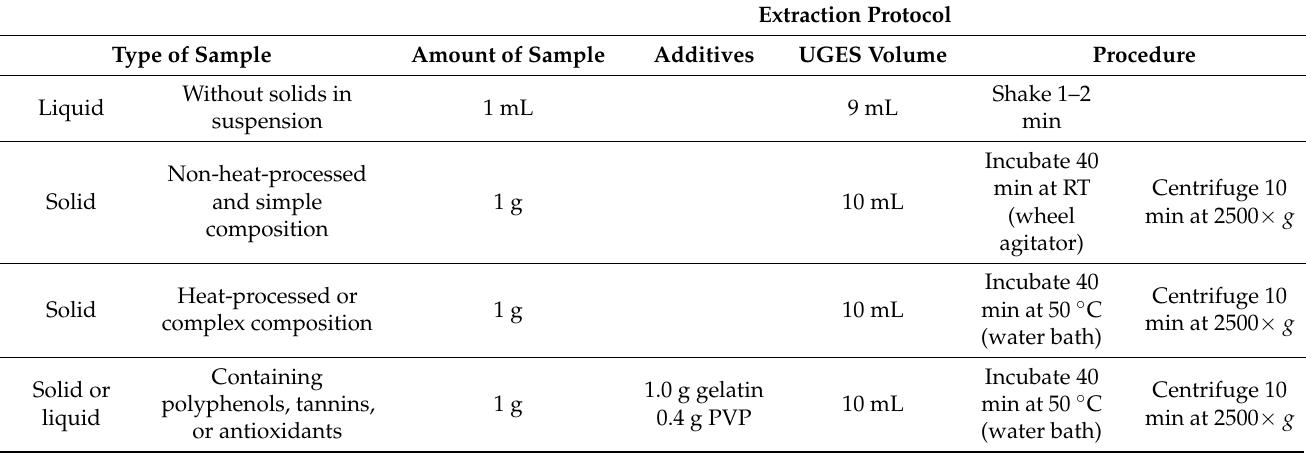
Table 1. Scheme of the steps in the extraction procedure with UGES depending on the type of sample. RT, room temperature.